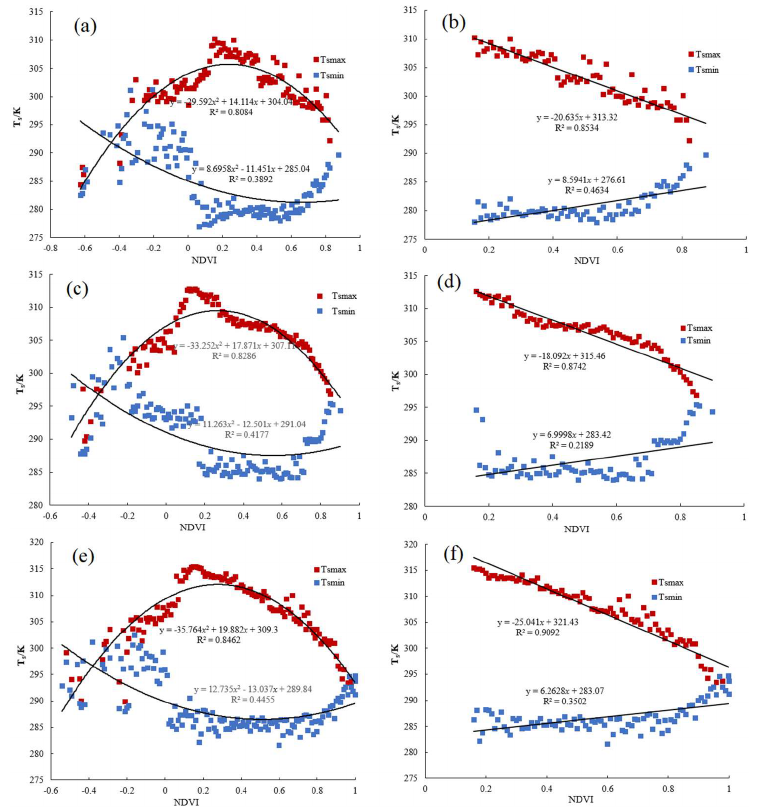
Figure 10. Comparison of scatter plots of bi-parabolic and triangular NDVI-T s space. ( a ) Scatter plots of bi-parabolic NDVI-T s space during 7 April 2013–14 April 2013, ( b ) scatter plots of triangular NDVI- T s space during 7 April 2013–14 April 2013, ( c ) scatter plots of bi-parabolic NDVI-T s space during 15